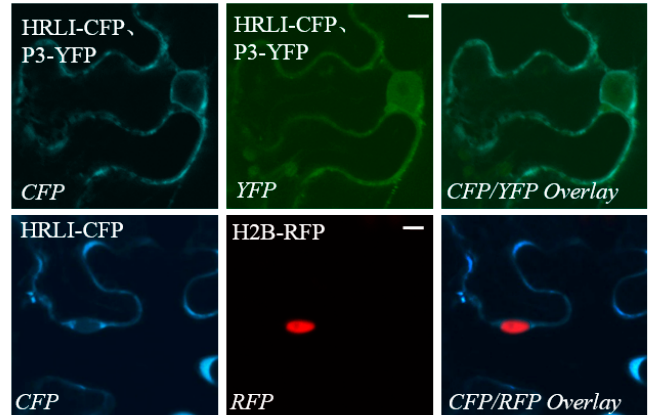
Figure 5. Localization of GmHRLI and co-localization with P3. C-terminal yellow flourescent protein (YFP)/CFP-tagged proteins were transiently expressed individually (GmHRLI-CFP, P3-YFP) or co-expressed (P3-YFP, GmHRLI-CFP) in N. benthamiana via agroinfiltration. Scale bars = 10 μ m. GmHRLI-CFP was expressed in transgenic plants expressing RFP-H2B (nuclear localized). Bottom italicized letters indicate the fluorescent channel used for imaging. Images are representative of three separate infiltrations from two independent experiments for C-terminal tagged flourescence proteins.